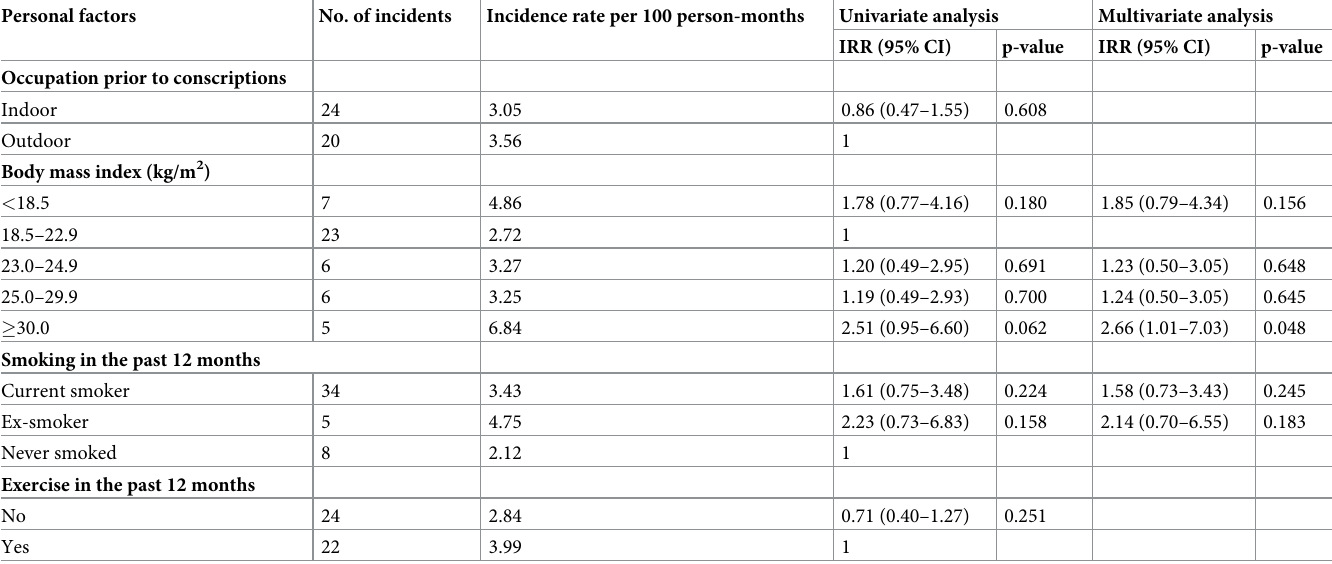
Table 3. Personal risk factors associated with heat-related illness among new conscripts during basic military training.